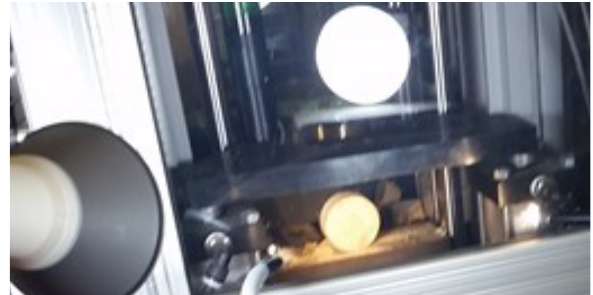
Figure 2. Impact testing machine, sample and lighting set up.